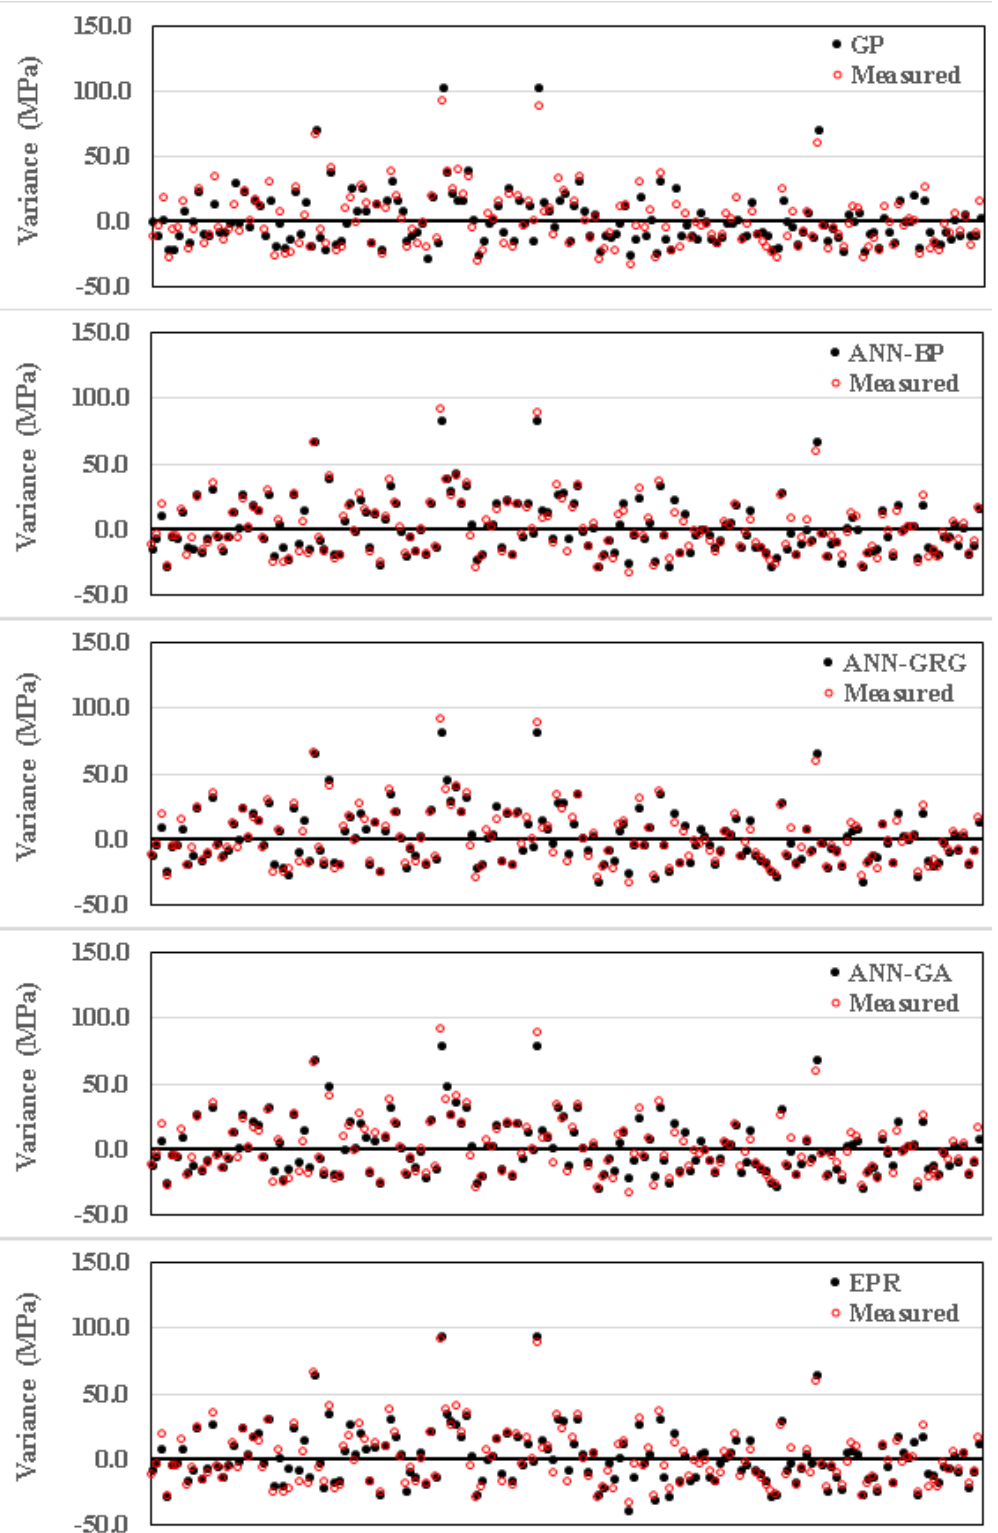
Figure 6. Variance diagram of measured and predicted models.